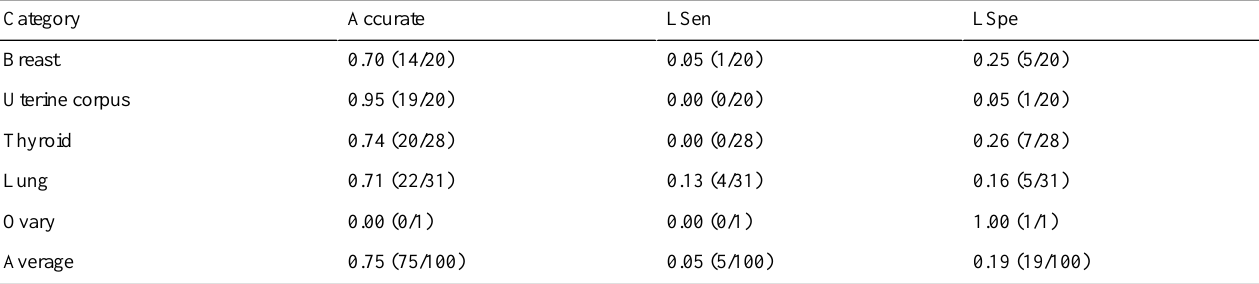
Table 7. Accuracy of diagnosis based on scanner VS by pathologist E. Results are presented as ratios between 0.00 and 1.00.